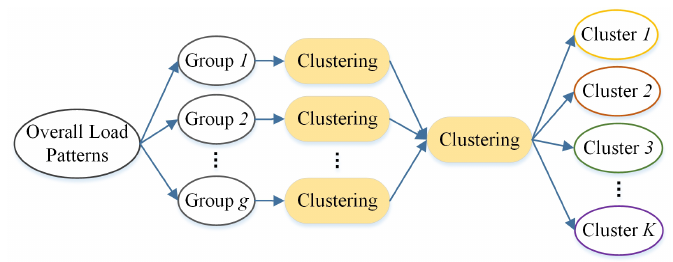
Figure 2. The procedure of load pattern clustering. The overall load patterns are randomly divided into g groups. Each group is clustered individually. The clustering centers of these g groups are gathered and clustered to form the final